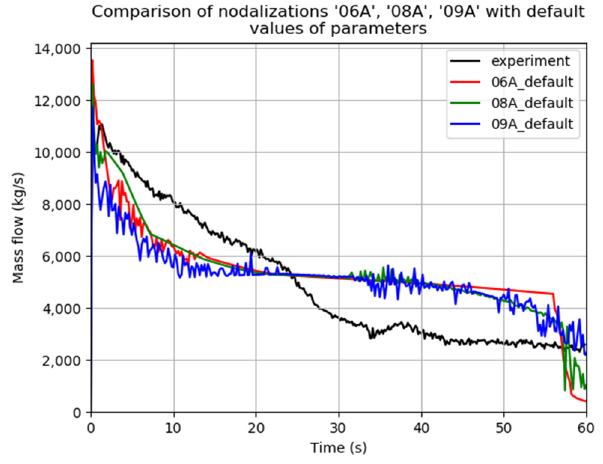
Figure 5. Mass flow rate for the models with 6, 8, and 9 CV 06A, 08A, and 09A nodalizations com-